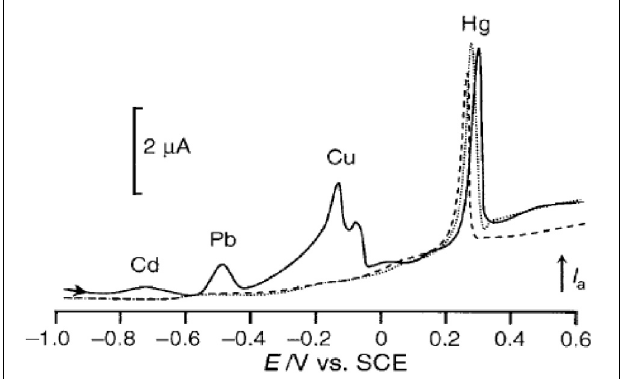
FIGURE 6 | DPV curves recorded at a poly(EDTA-like) film modified carbon electrode in acetate buffer containing Hg(OAc) 2 (dotted line), Cu(OAc) 2 , Cd(NO 3 ) 2 , Pb(NO 3 ) 2 , Hg(OAc) 2 (full line). Reprinted with permission from Buica et al. (2009b). Copyright 2009